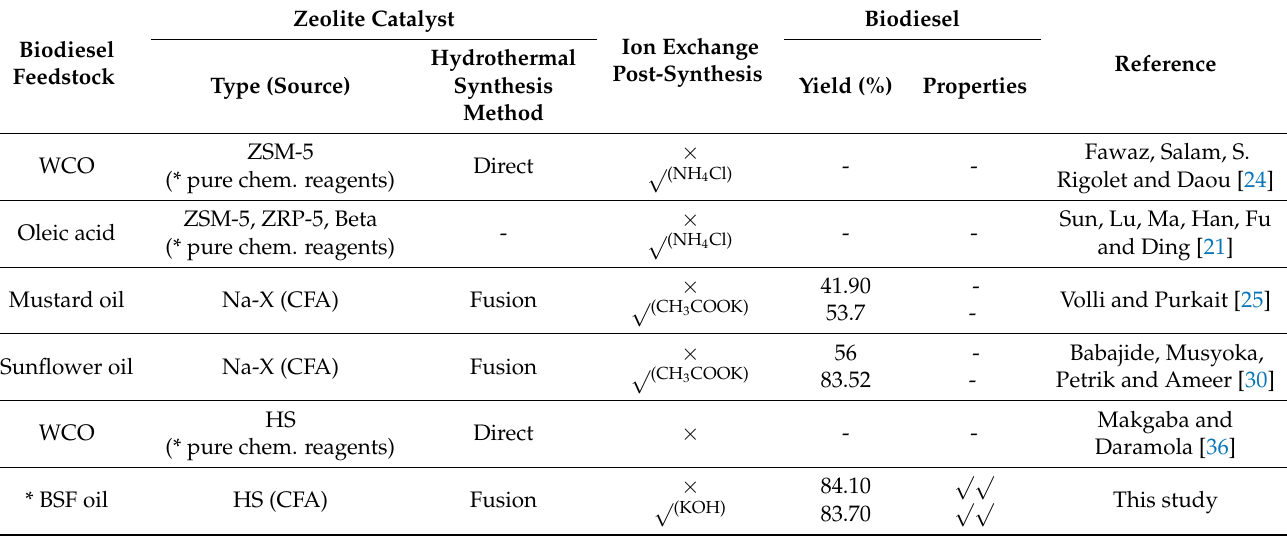
Table 4. The performance of fly ash-derived and ion exchange-modified HS zeolite in biodiesel production compare to the literature’s counterpart HS zeolite